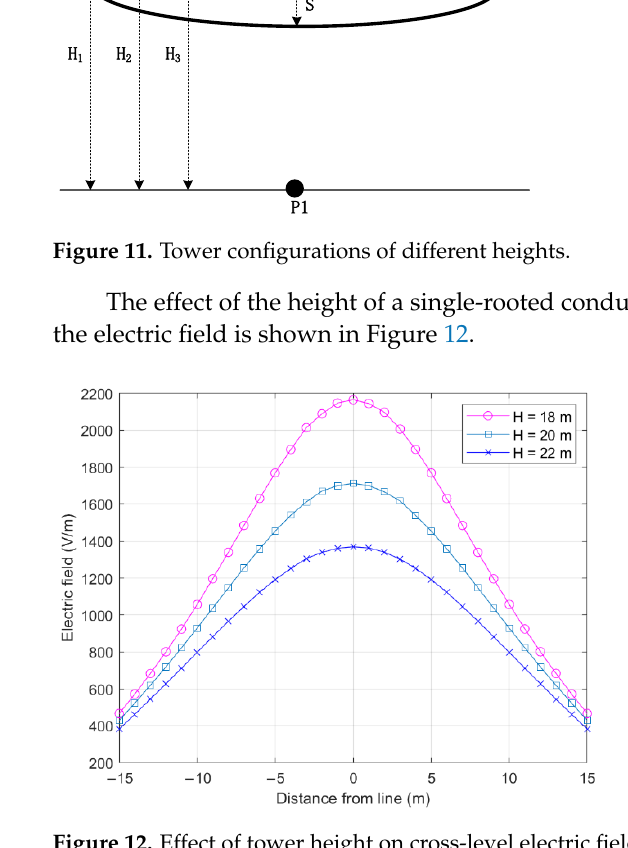
Figure 12. Effect of tower height on cross-level electric field.